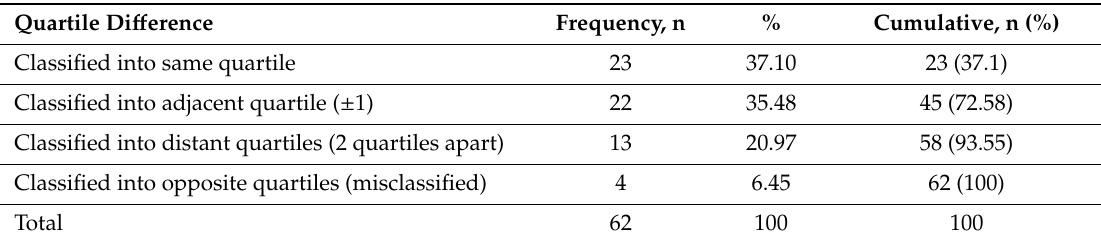
Table 1. Quartile correlation of vitamin D intake from food frequency questionnaire and three-day food records.